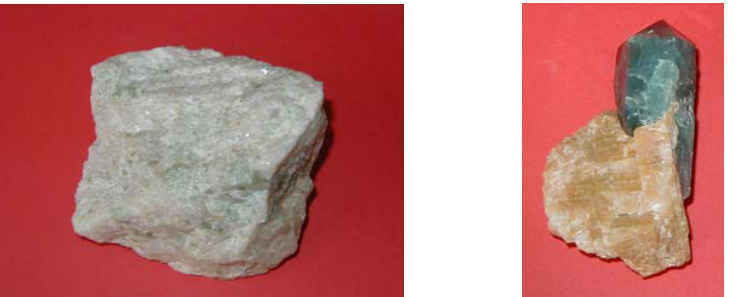
Figure 1. Polycrystalline (left) and single-crystalline (right) FA of a geological origin. The single crystal has a grey-green color due to incorporated ions of transition metals